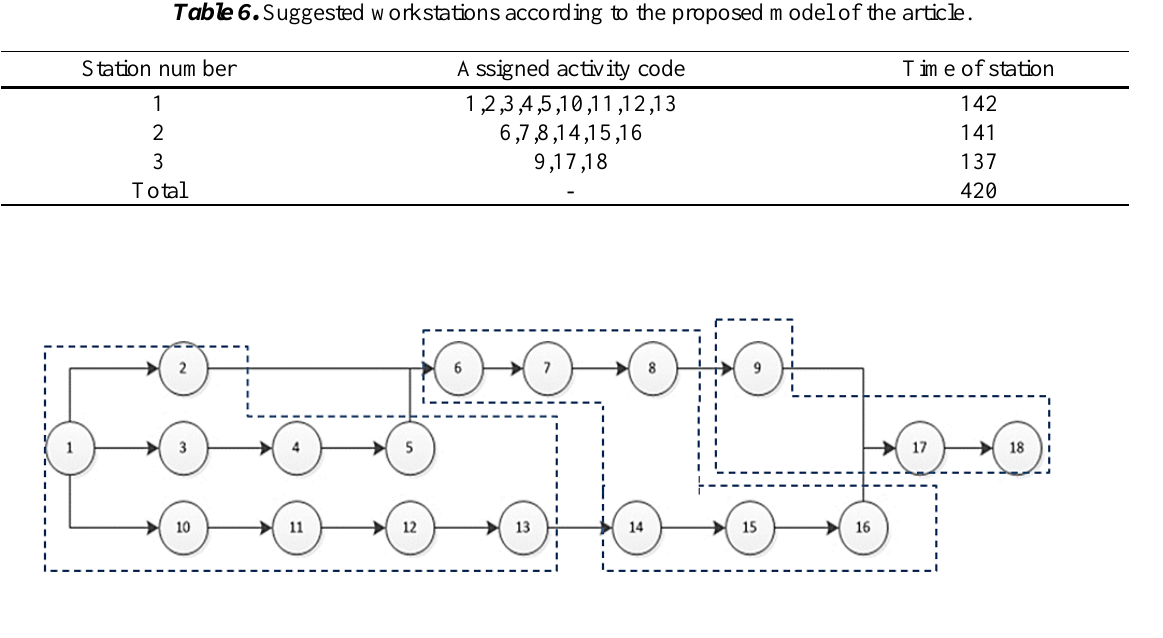
Figure 2. Workstation diagram of the proposed condition of the